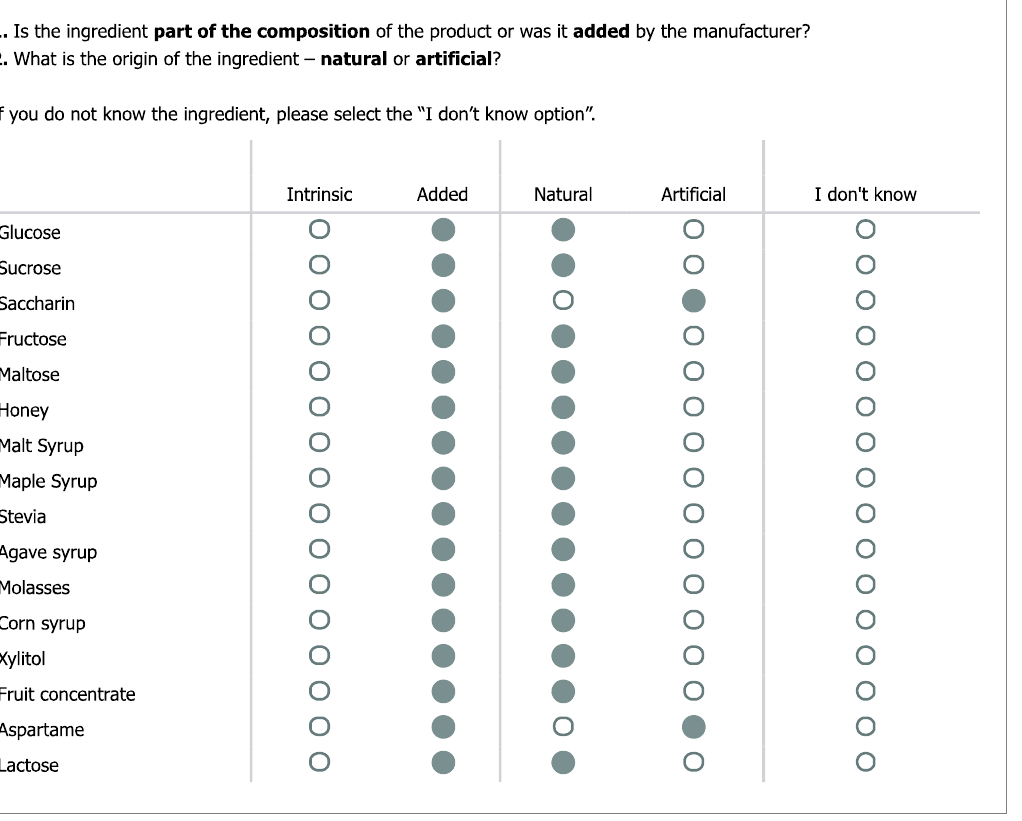
Figure 1. Categorization of sugar sources task (Qualtrics). Sugar sources were presented in random order. The options selected represent the correct answers (hits). Original instructions and items were presented in Portuguese.